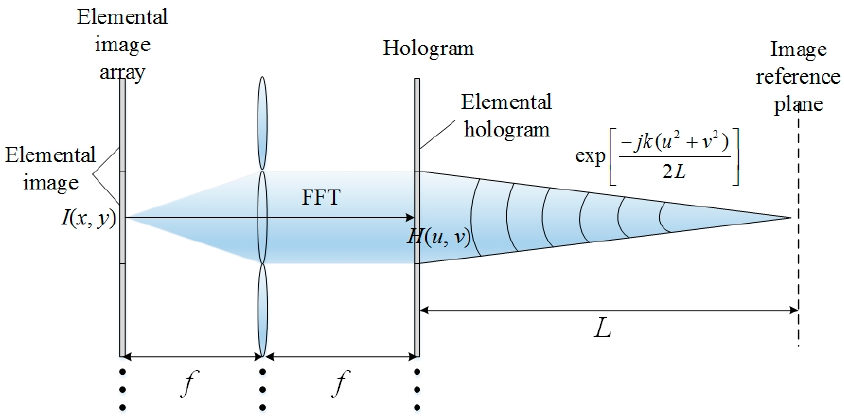
Figure 1. The principle of RPHS.